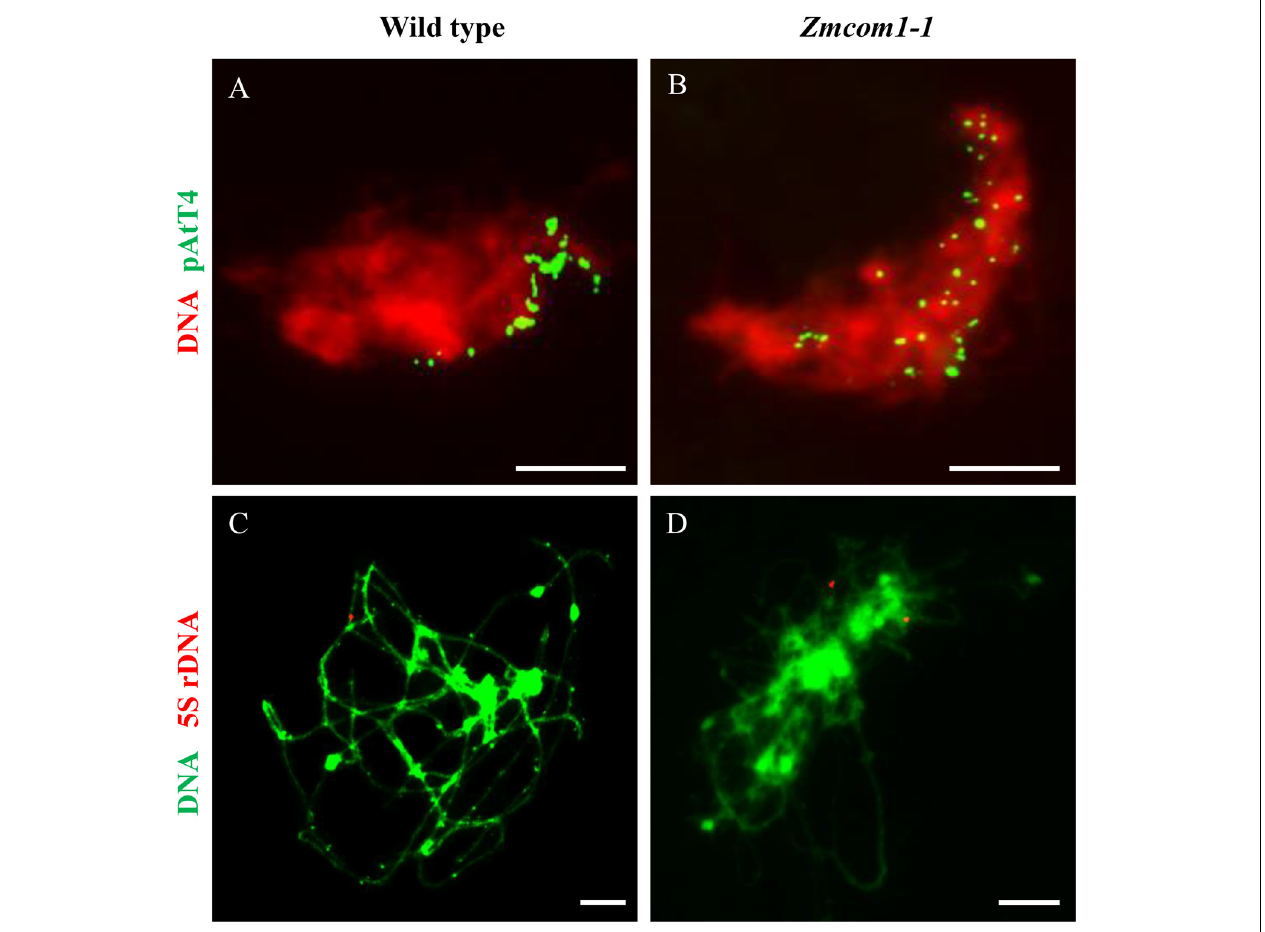
FIGURE 4 | ZmCom1 is essential for bouquet formation and homologous pairing. (A,B) Bouquet formation analysis using FISH with the telomere-specific pAtT4 probe in in the wild type (A) and Zmcom1-1 (B) . Scale bars = 10 µ m. (C,D) Homologous pairing analysis using FISH with 5S rDNA probe in in the wild type (C) and Zmcom1-1 (D) . Scale bars = 10 µ